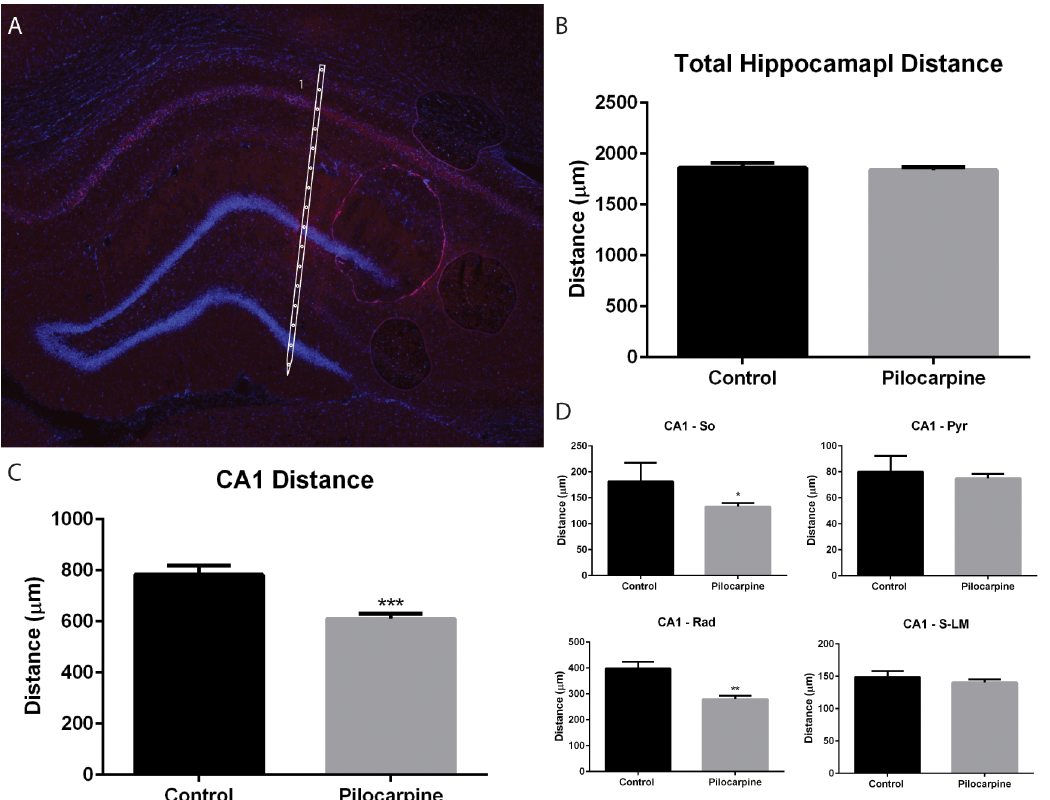
Fig 2. Pilocarpine-induced morphological changes. A) Reconstruction of silicon probe placement within a coronal section of the hippocampus. Scaled silicon probe outlines were superimposed on sections counterstained with DAPI. DiI tracks and multiunit activity guided probe alignment. B) No differences in the distance from stratum oriens in CA1 to the outer molecular layer of the inferior blade of the dentate gyrus were seen between control and pilocarpine animals. C) There was a significant decrease in the distance taken up by area CA1 in pilocarpine-treated animals measured from stratum oriens to the hippocampal fissure. D) Further analysis of CA1 demonstrated a significant decrease in stratum oriens and stratum radiatum in pilocarpine-treated animals, with no change to the pyramidal cell layer or stratum